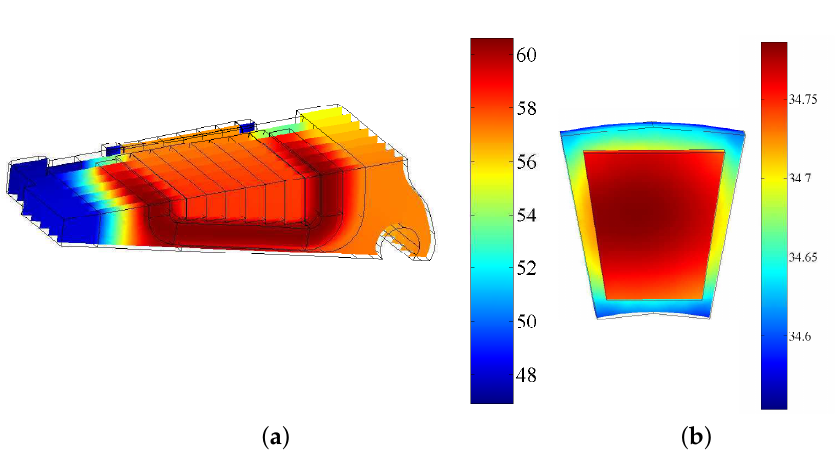
Figure 9. Spatial temperature distribution in degrees Celsius: ( a ) Stator; ( b ) Rotor.